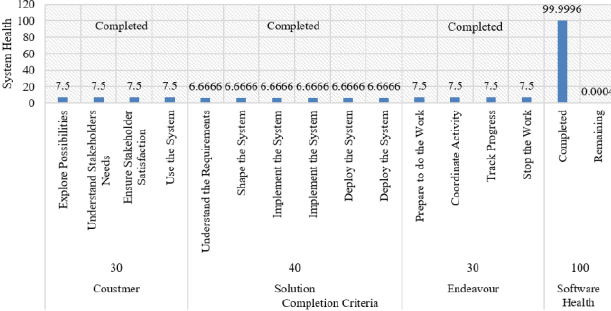
Fig. 6. Software Health after the Customer area of concern completed